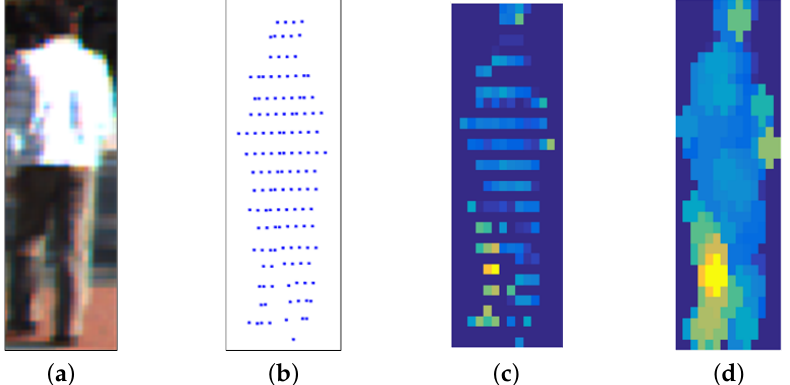
Figure 3. Projection-image generation. ( a ) Pedestrian optical image; ( b ) corresponding point clouds; ( c ) projection image generated by projecting point clouds onto main plane; ( d ) result of morphological processing on ( c